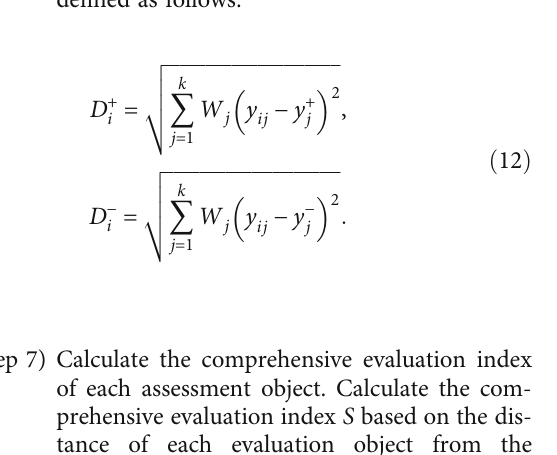
Figure 3: The complex network topology of the disc assembly